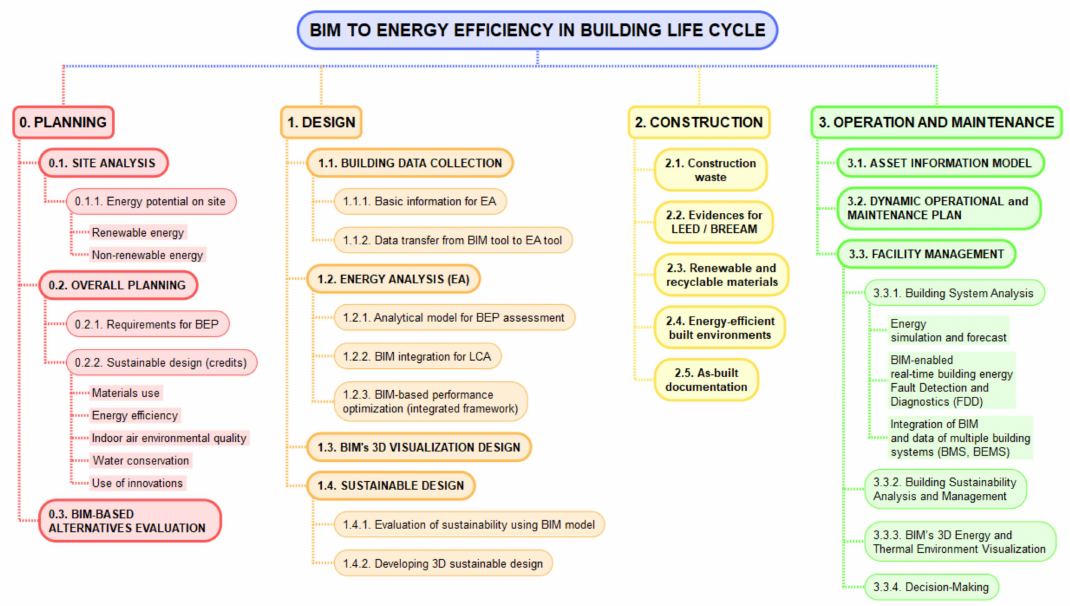
Figure 9. BIM contribution to energy efficiency during the building life